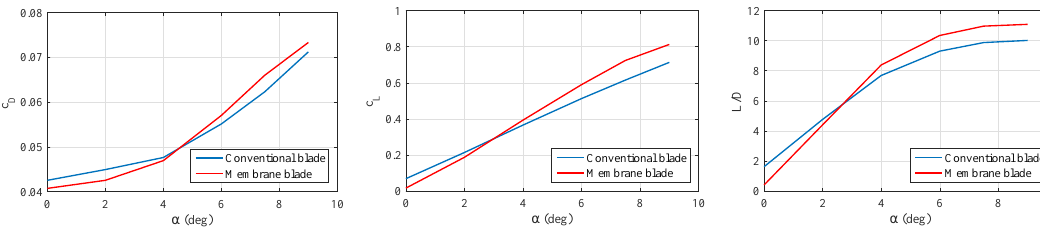
Figure 18. Comparison between the aerodynamic characteristics of the membrane blade and rigid blade.